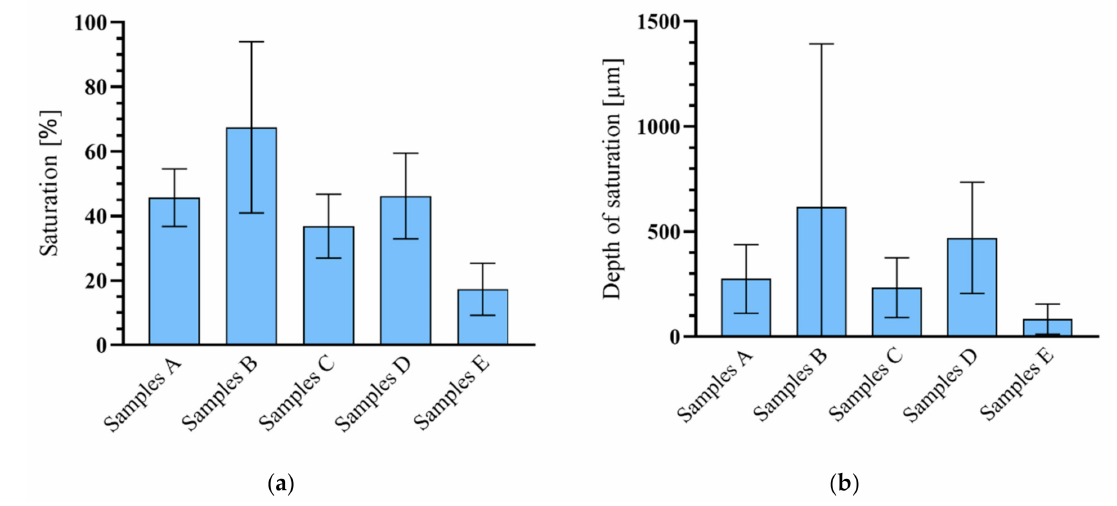
Figure 12. Evaluation of microscopic research of textile reinforcement saturation: ( a ) Fiber saturation expressed as a percentage; ( b ) Average depth of textile reinforcement saturation. Legend: Samples A—Experimental samples saturated with CEM 42.5 R using pressure saturation; Samples B—Experimental samples saturated with CEM 52.5 R using pressure saturation; Samples C—Experimental samples saturated with CEM 42.5 R using surface saturation by a roller; Samples D—Experimental samples saturated with CEM 52.5 R using surface saturation by a roller; Samples E—Experimental samples without